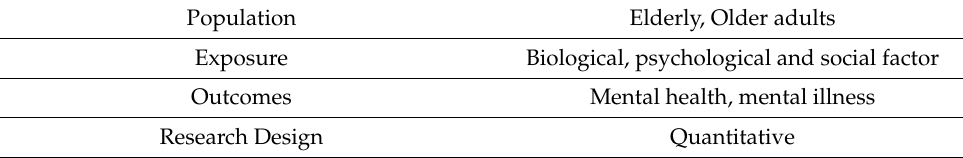
Table 1. PEO Framework for determining the eligibility of the scoping review